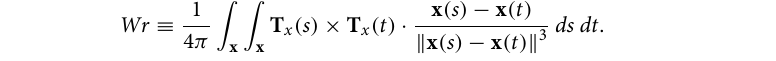
search algorithm. 4. Use Eq. (9) to calculate W pnl (a branch cut tracking method is used to track full